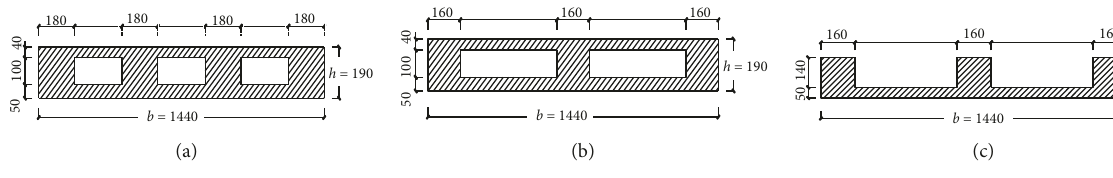
Figure 12: Sectional moment of inertia calculation diagram: (a) Slab S1; (b) Slabs S2 and S3; (c) Slab